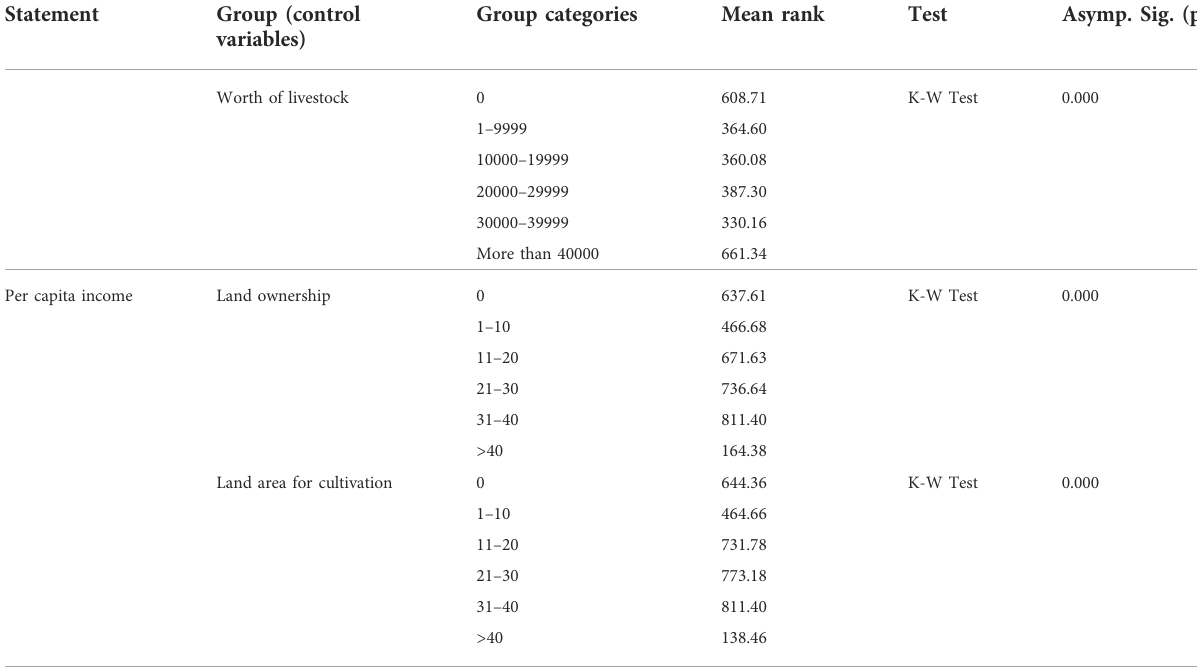
TABLE 8 Signi fi cance of livestock and land on the per capita income from the previous year.